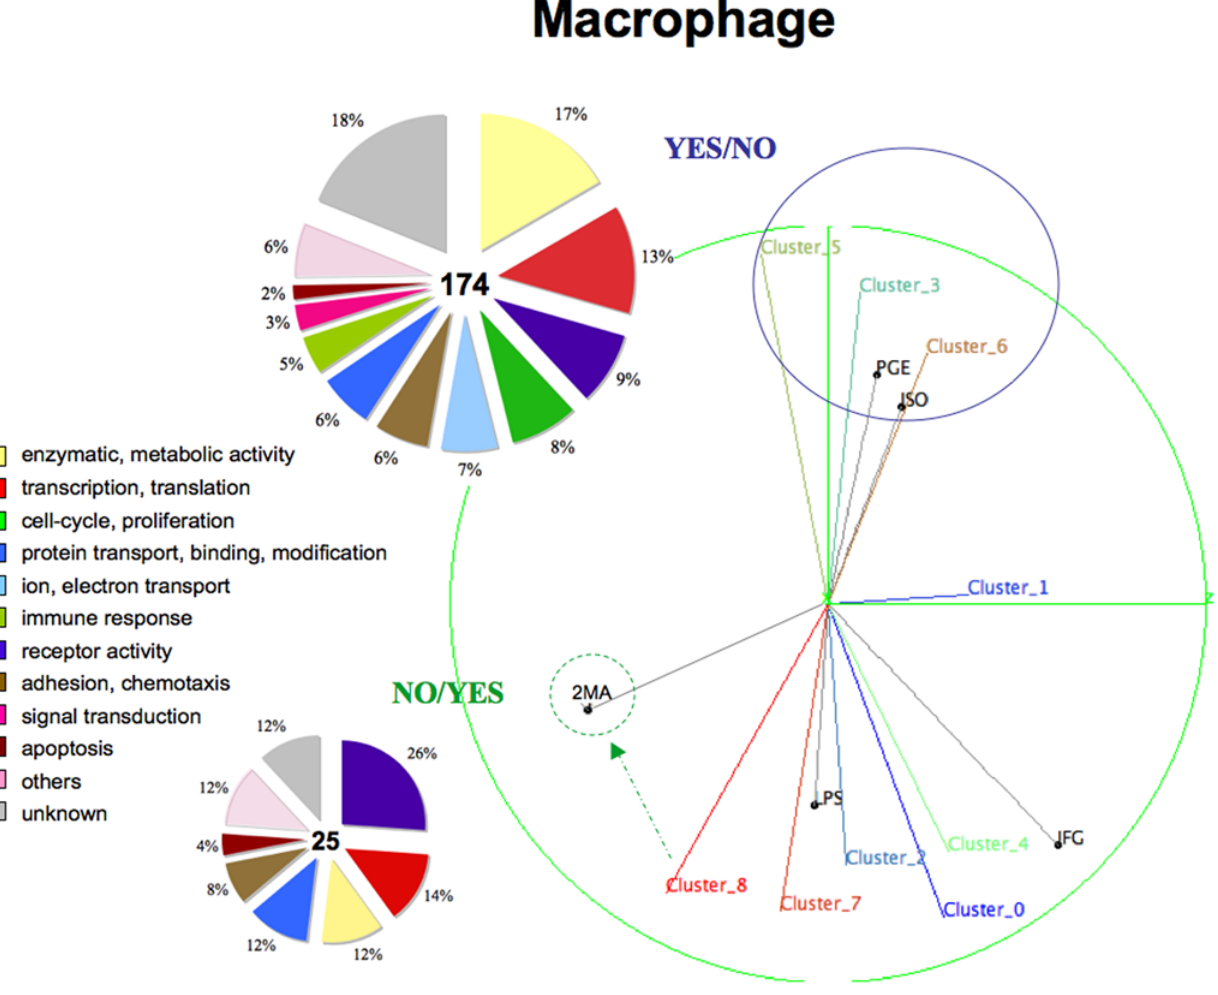
Figure 5. Clustering results on 5 macrophage ligands with available microarray expression data: PGE, ISO (YES/NO), 2MA (YES/YES) and LPS, IFG (NO/NO). Two cAMP-activated ligands (PGE and ISO) form a distinct sub -region within the hyperspace. NO/NO ligands (LPS and IFG) do not form a single sub -region. 2MA is an only YES/YES ligand remoted from YES/NO sub -region as well as from NO/NO ligands. Possibly Cluster_8 is the influenced by 2MA. This representation, which we call ‘PCA correlation ball’, shows both the groups of ligands and their correlations, and also the regulations of gene clusters from the projections of nearby ligands. Genes functions (‘Function’ or ‘Cellular process’ (GO terms), if ‘Function’ is absent) calculated basing on the enrichment in clusters with p-value , 0.05 are shown in the pie-graphs. By the reason of small number of genes we combined up- and down- regulated gene together in the pie-graphs.